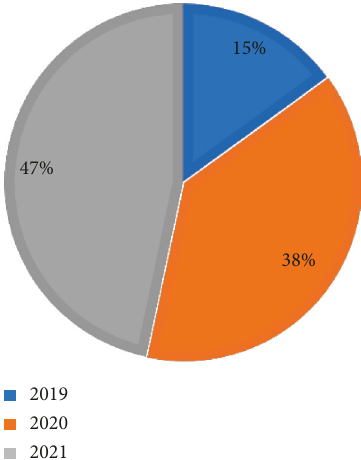
Figure 5: Number of articles based on